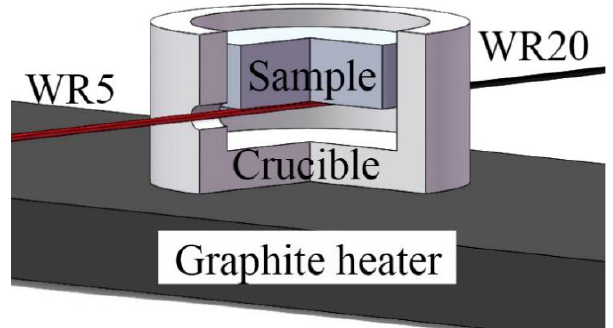
Figure 3. Schematic illustration of RSM ignition.